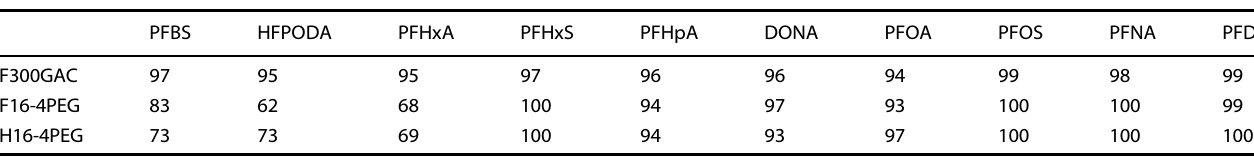
Table 1. Gravity fi ltration